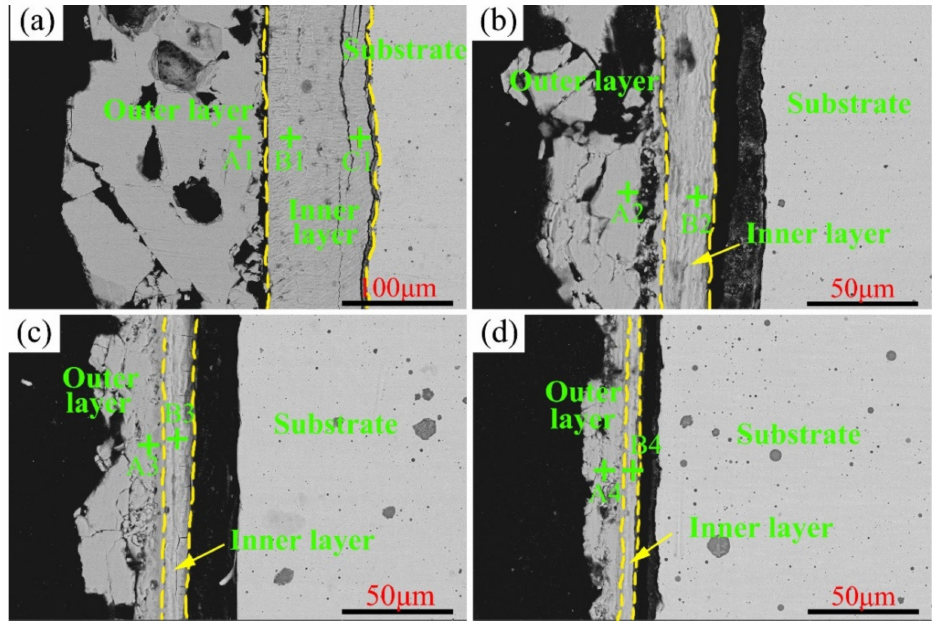
Figure 10. Cross-section morphology of Ni–xCr–Mo laser-cladding coatings observed under back-scattered mode after the sulfur corrosion test at 550 ◦ C for 168 h: ( a ) C1, ( b ) C2, ( c ) C3, and ( d ) C4. Table 5. EDS results (at.%) of typical points displayed in Figure 10.